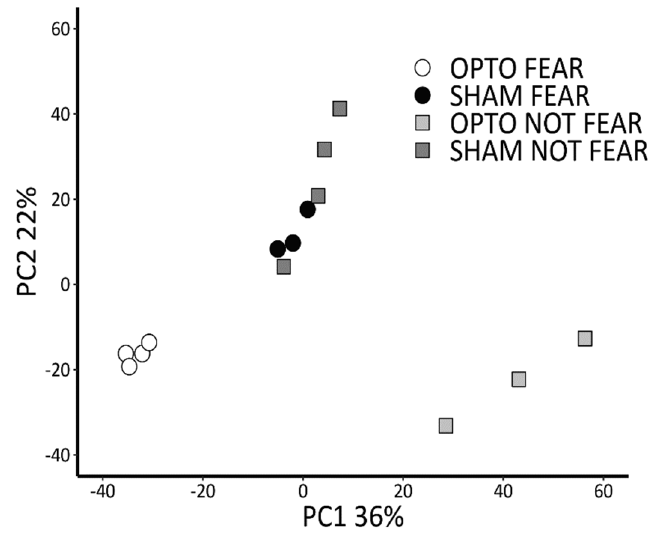
Figure 4. Principal Component Analysis revealing sample clustering based on gene expression profiles. While gene expression profile of mice belonging to SHAM FEAR and SHAM NOT FEAR groups appeared clustered, those of individuals belonging to OPTO FEAR and OPTO NOT FEAR groups were markedly segregated.